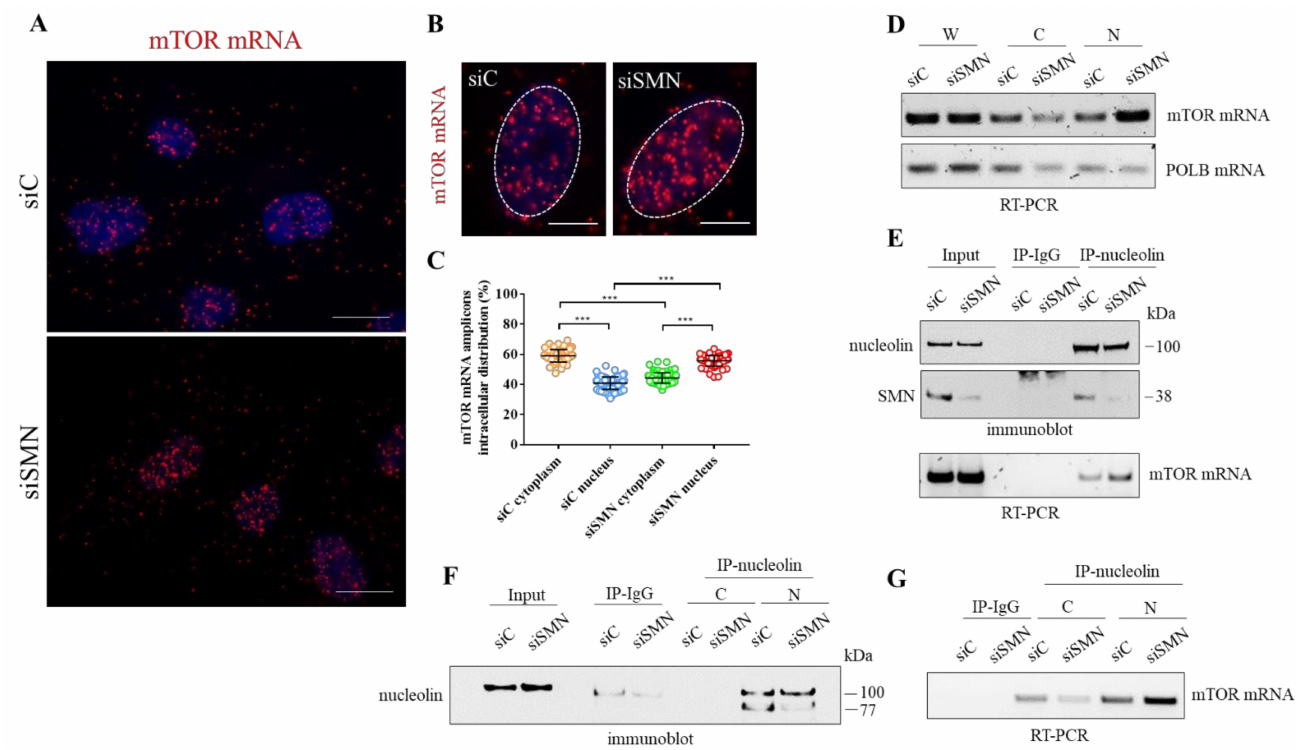
Figure 4. Subcellular distribution of mTOR mRNA. ( A ) Representative images of padlock assay targeting mTOR mRNA (red dots), in siC- or siSMN-transfected hTert-Fibroblasts. Nuclei were stained with DAPI. Scale bar 10 µ m. ( B ).